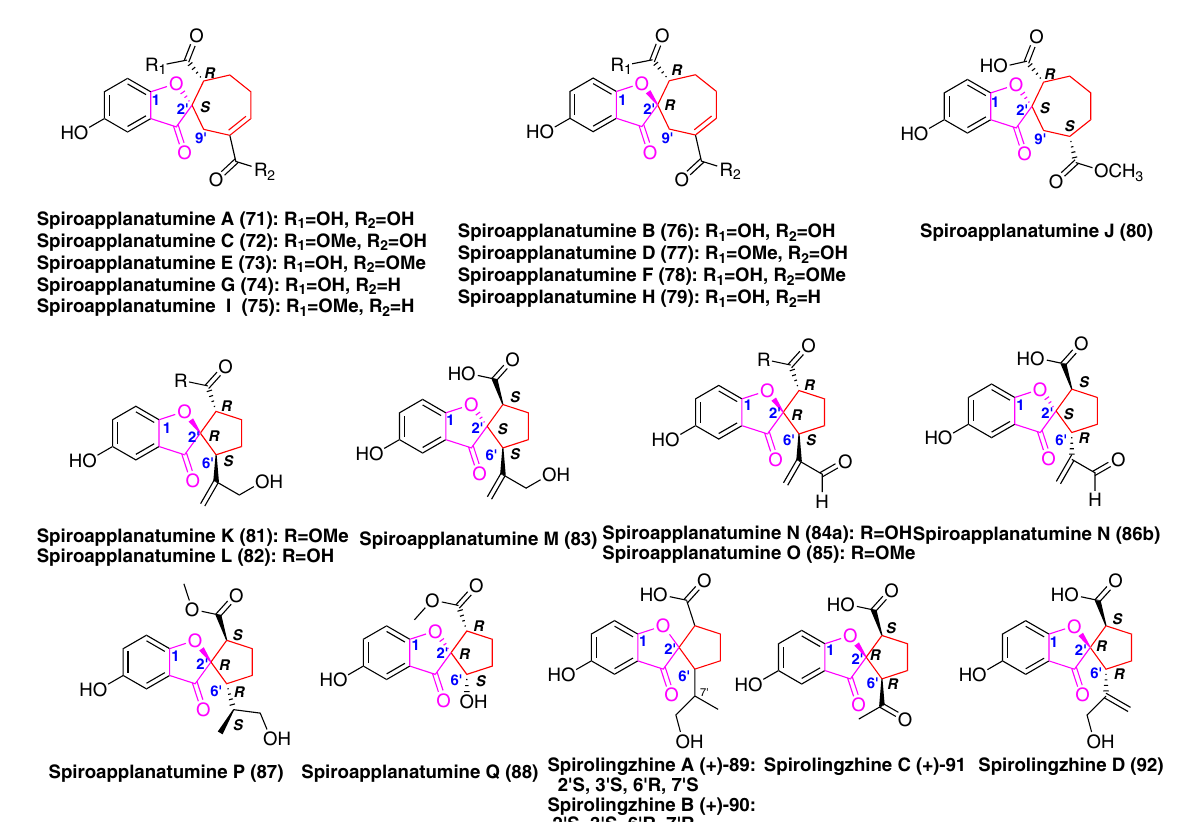
Fig. 6 Structures of GMs with spiro